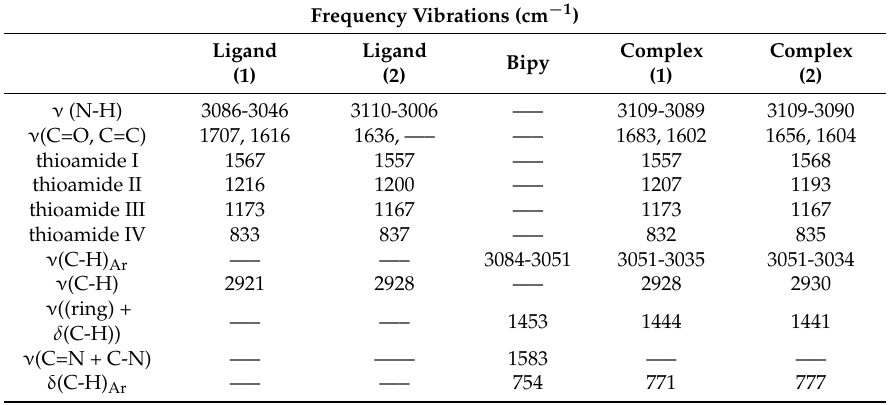
Table 1. Modes and vibrational frequencies of Bipyridine, ligands L 1 and L 2 , and complexes 1 and 2